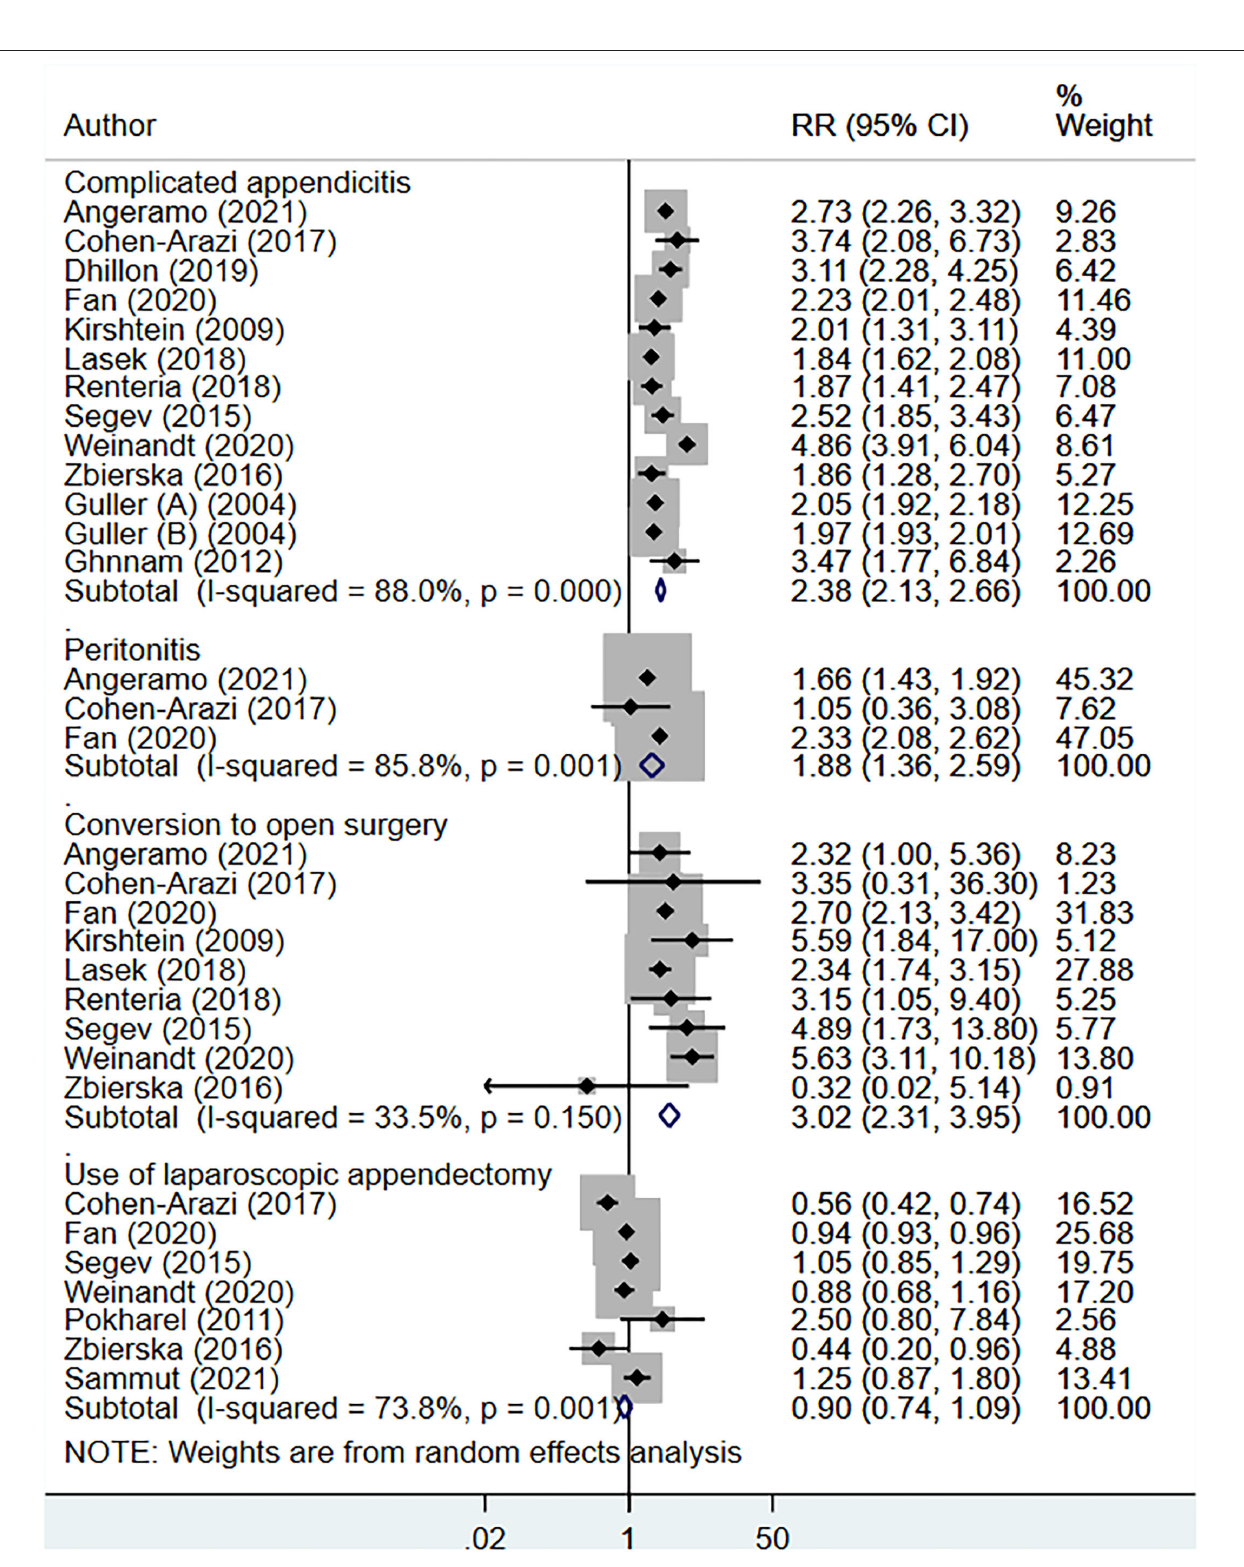
FIGURE 3 | Clinical outcomes of appendectomy among elderly subjects, compared to non-elderly subjects.